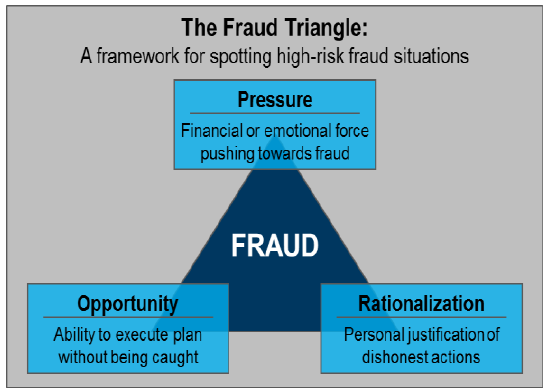
Figure 1. The Fraud Triangle Resource: Brumellgroup,